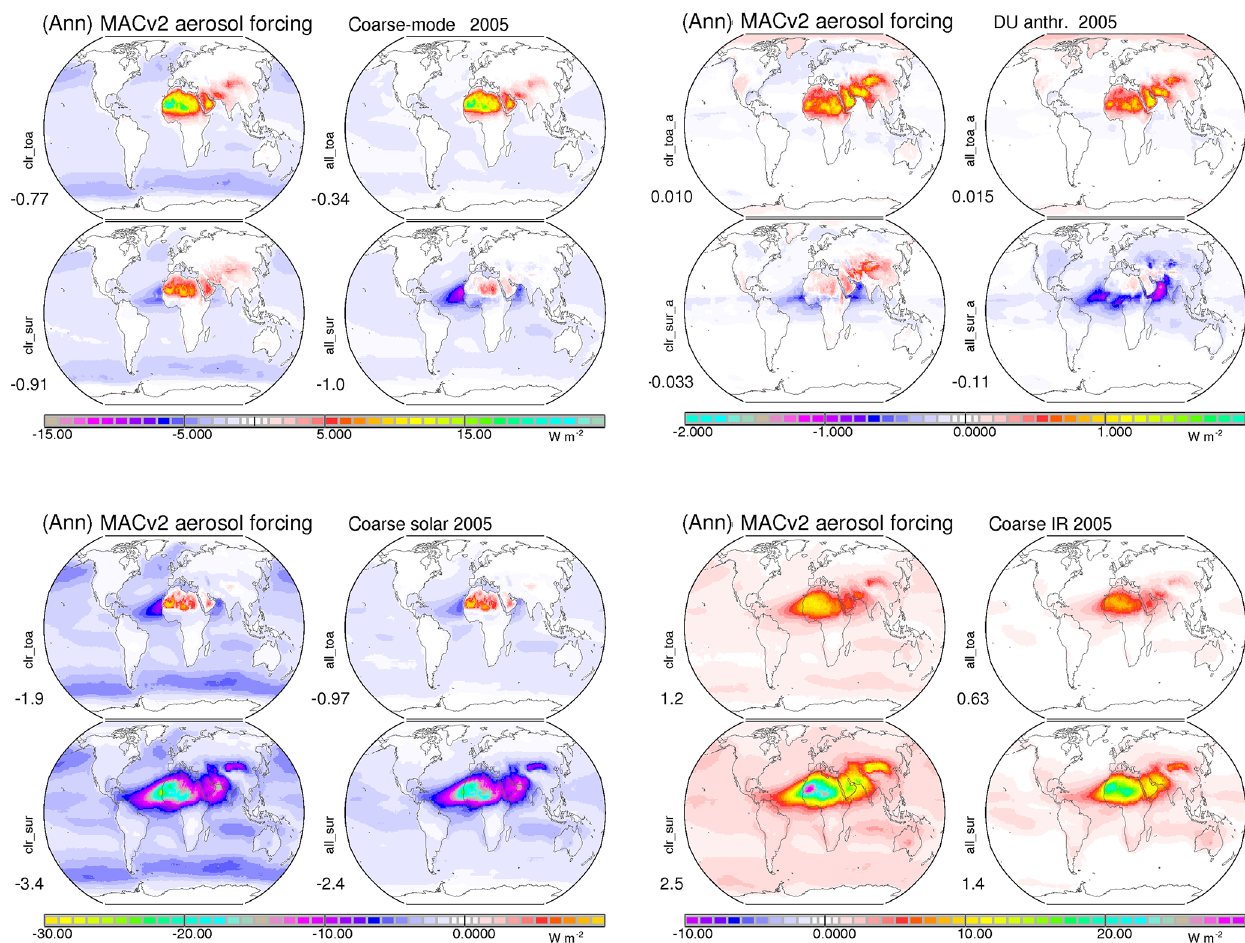
Figure 8. Annual maps for the coarse-mode aerosol direct radiative effects at the TOA (top) and surface (bottom) for clear-sky (left) and all-sky (right) conditions. Coarse-mode effects (top left frame) are compared to potential anthropogenic contributions (top right frame, note its 10 times smaller color-scale range). Blue to purple colors indicate a cooling and red to yellow colors a warming. In addition, solar (bottom left frame) and IR contributions (right bottom frame) to the coarse-mode aerosol direct radiative effects are presented. Note the different scales. Values below the labels indicate global